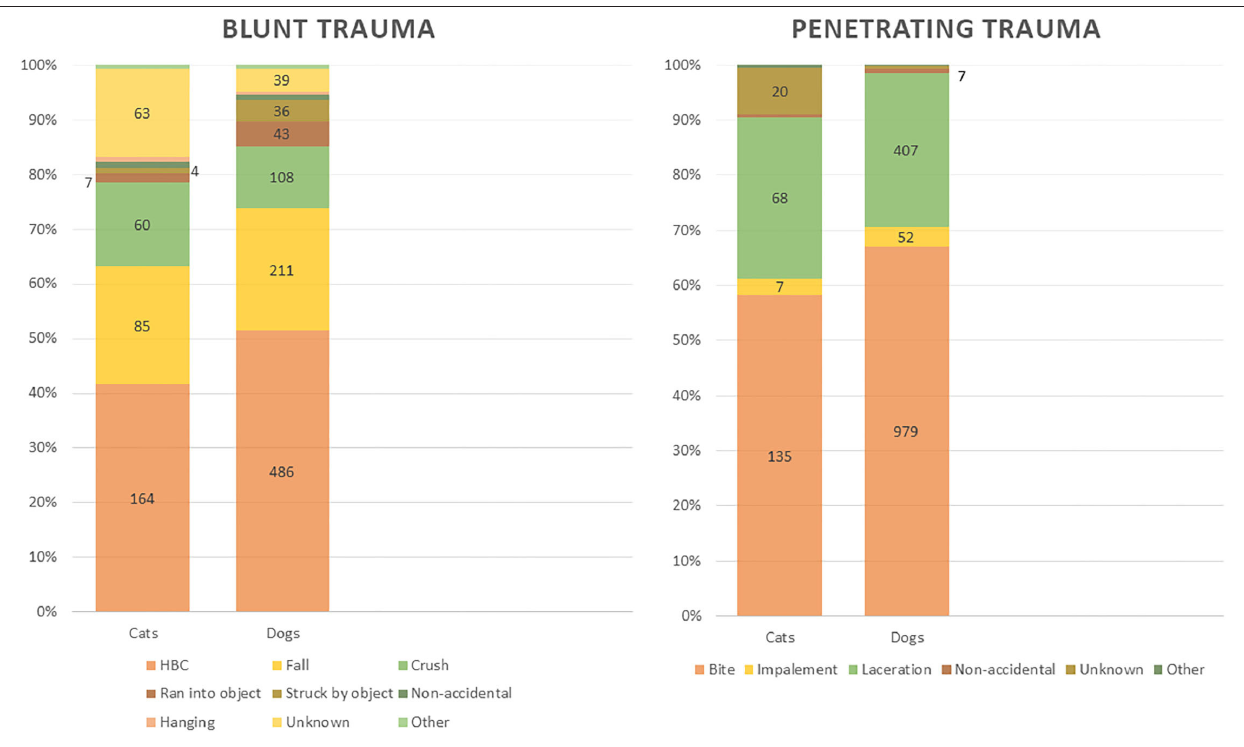
FIGURE 3 | Penetrating and Blunt Trauma subtype distribution of cats and dogs for all time